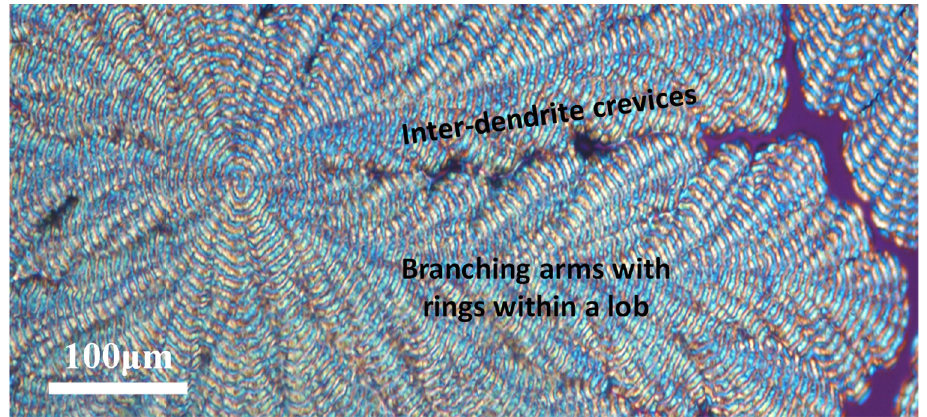
Figure 3. POM graph showing multiple-lob dendritic banded PPDO growing lengthwise (crystallized from PPDO/PVPh = 80/20, T c = 80 °C.